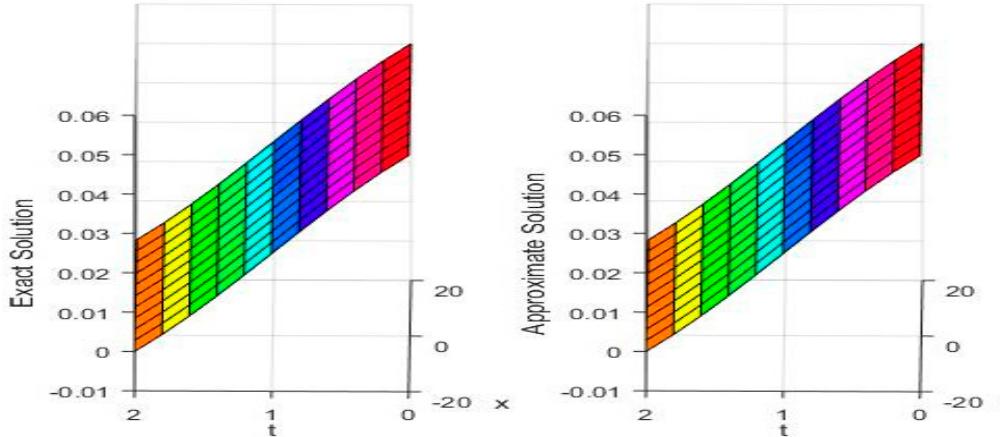
Figure 2. Behavior of exact ( Left ) and approximate solutions ( Right ) of 𝑣 for Test Problem 1.